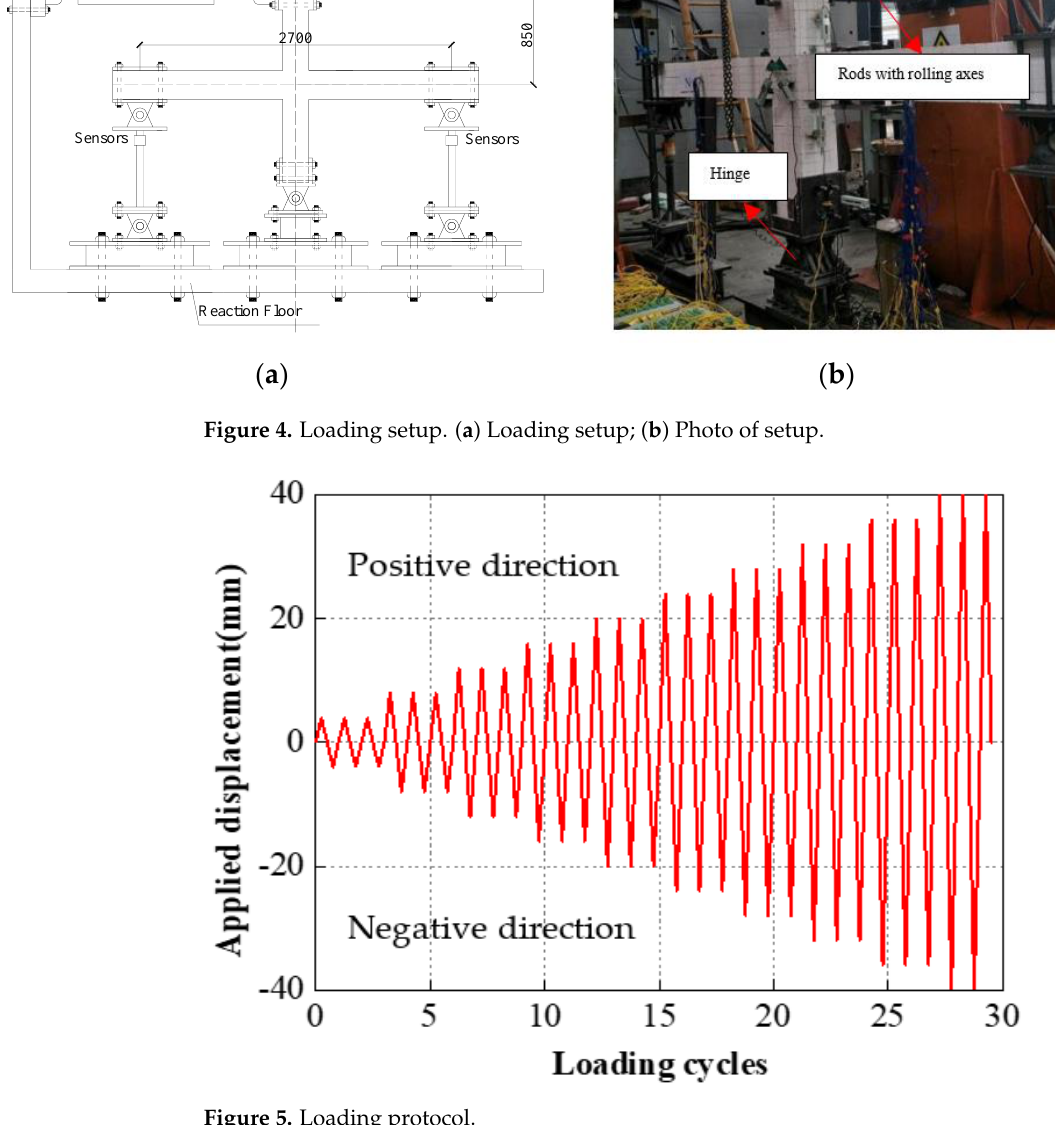
Figure 4. Loading setup. ( a ) Loading setup; ( b ) Photo of setup.